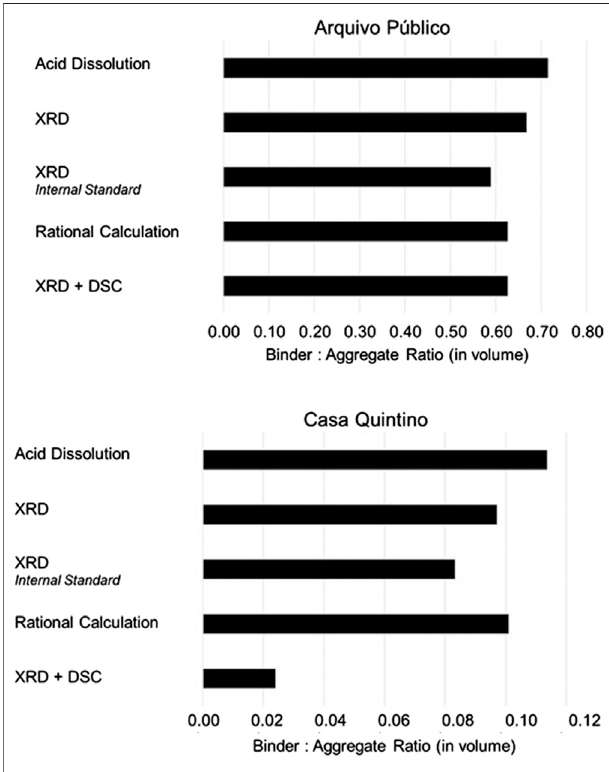
FIGURE 10 | Binder: aggregate ratio in volume identi fi ed by all methods and analytical techniques: (A) Arquivo Público and (B) Casa Quintino.